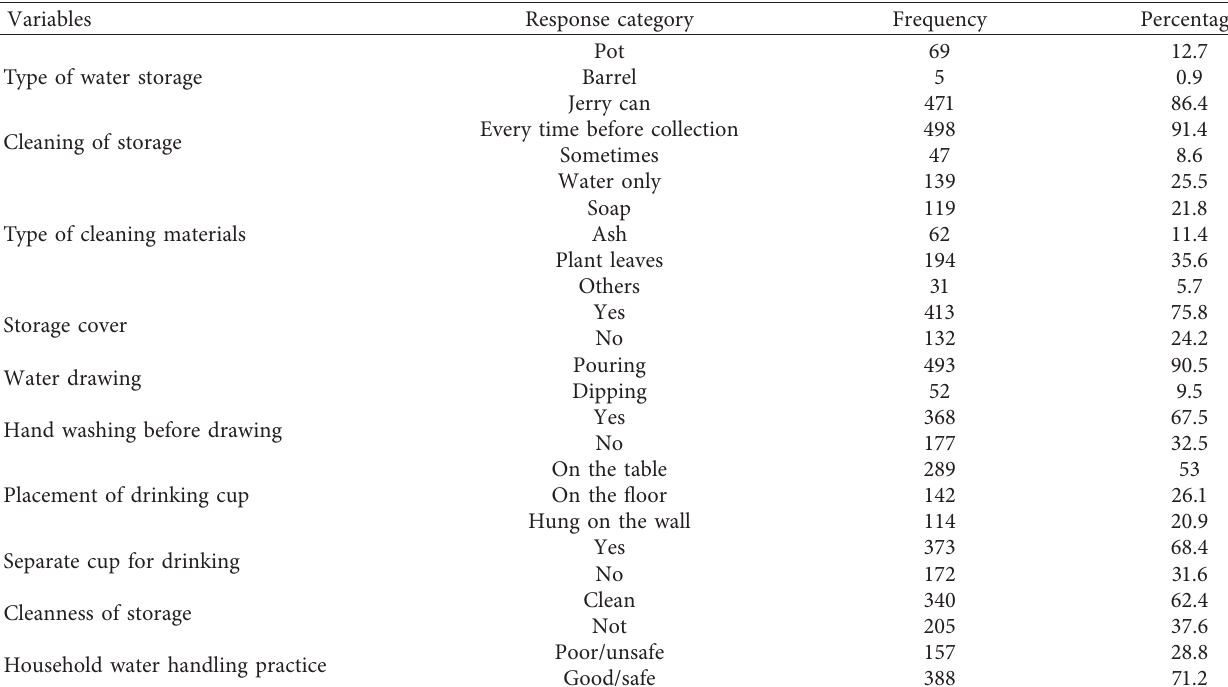
Table 3: Water handling related to storage and usage by households in Boloso Sore woreda, Wolaita zone, Ethiopia, January 2019.